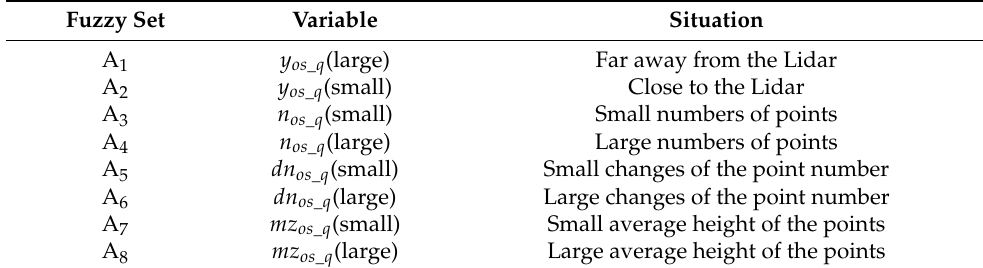
Table 4. The relationship between the fuzzy sets and situations.